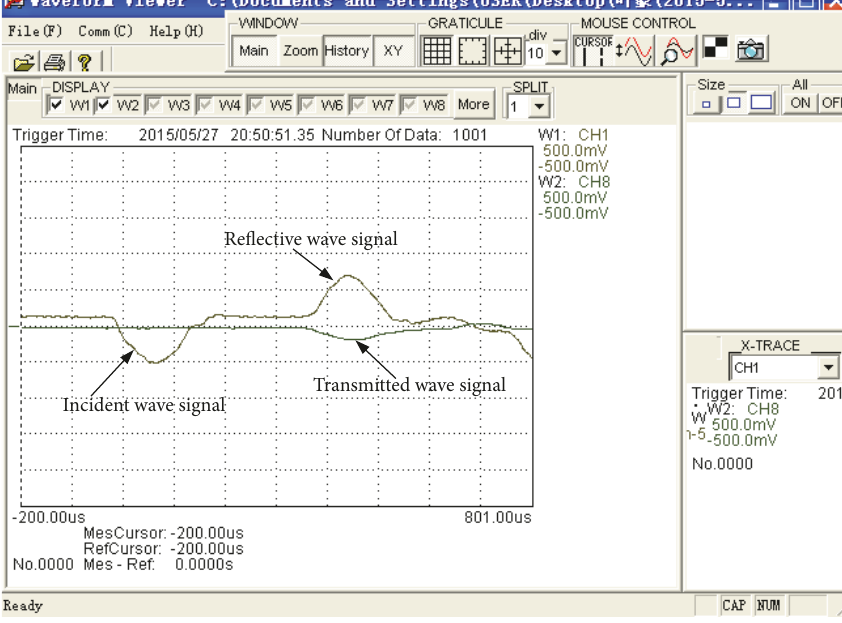
Figure 3: Incident wave, reflective wave, and transmitted waves recorded during the impact test.